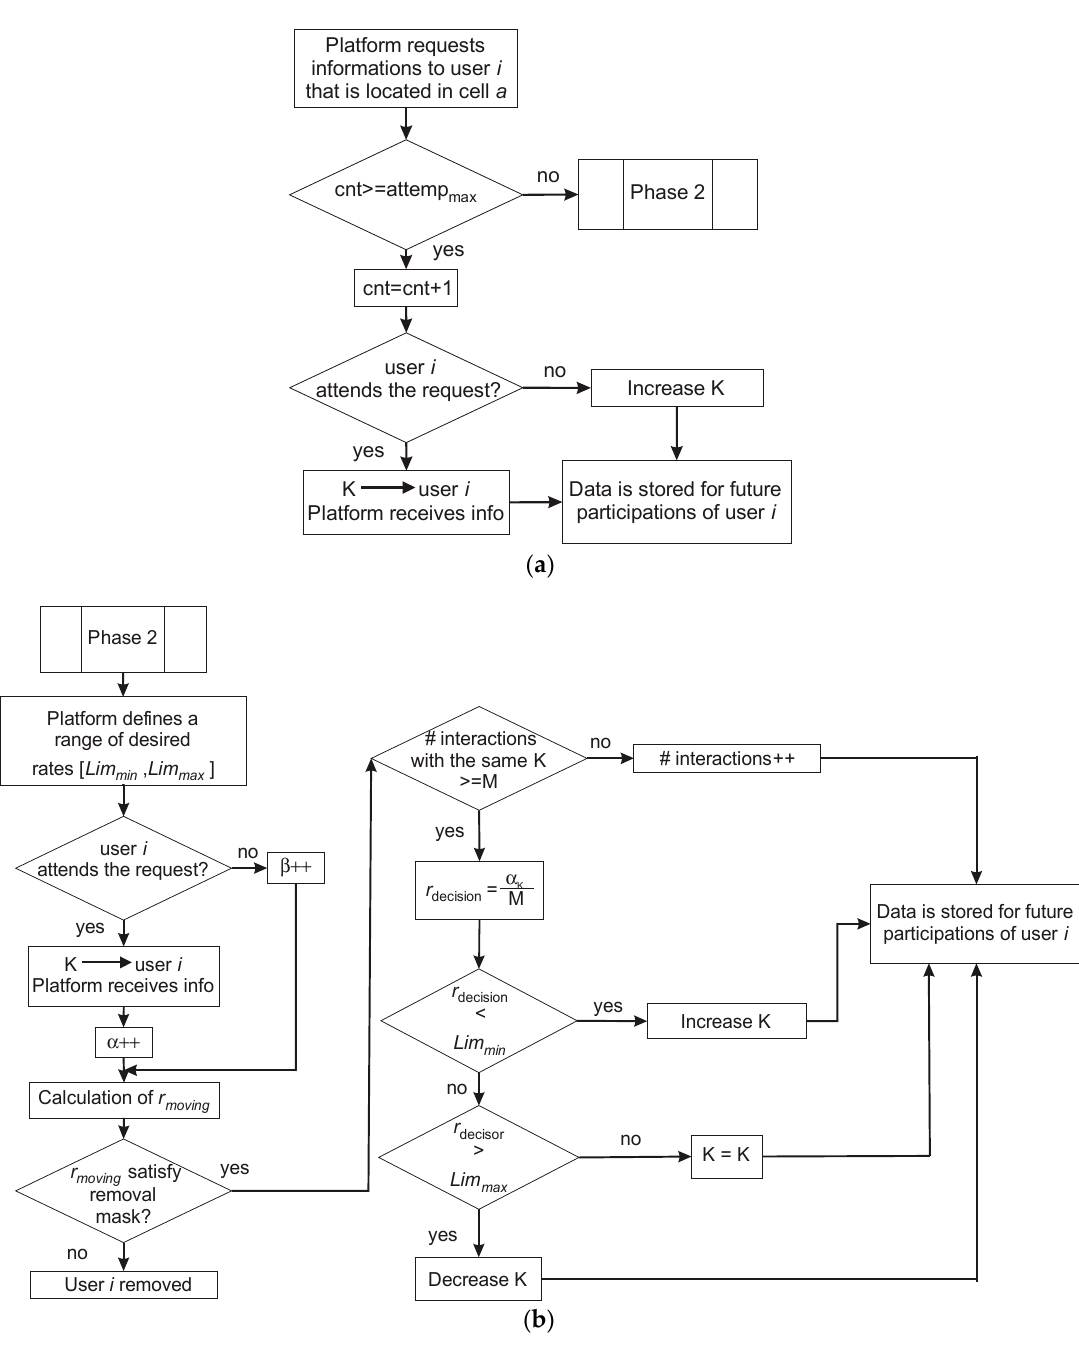
Figure 10. ( a ) Flowchart of the incentive mechanism in its first stage; ( b ) Flowchart of the incentive mechanism in its second stage.